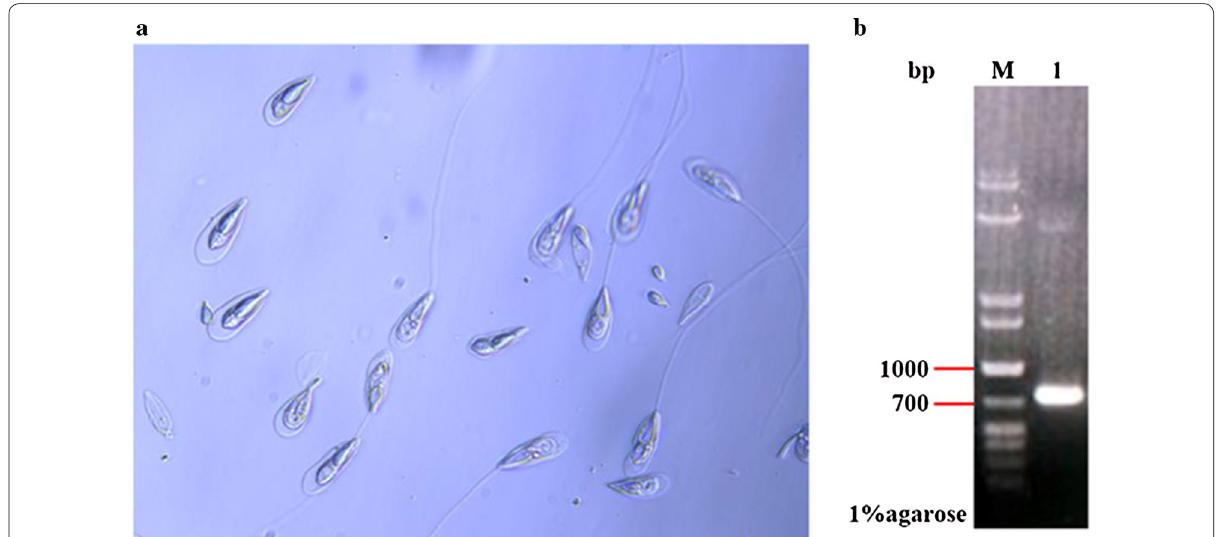
Fig. 1 Identification of T. kitauei . a Light micrograph of parasite spores stained with 1% crystal violet solution (40X). b 18S rDNA PCR amplification product of T. kitauei . Line M: DNA marker (MD113, TIANGEN); Line 1: 18S